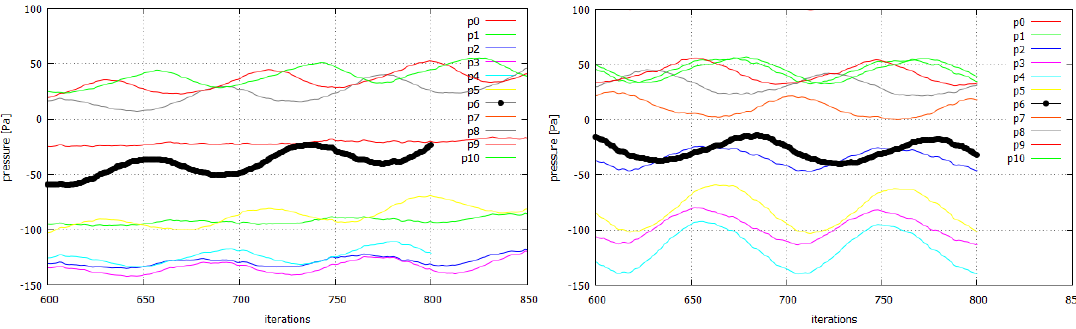
Figure 10: Pressure evolution along the diaphragm at points p0,...p10 for cases C2 (left) and D2